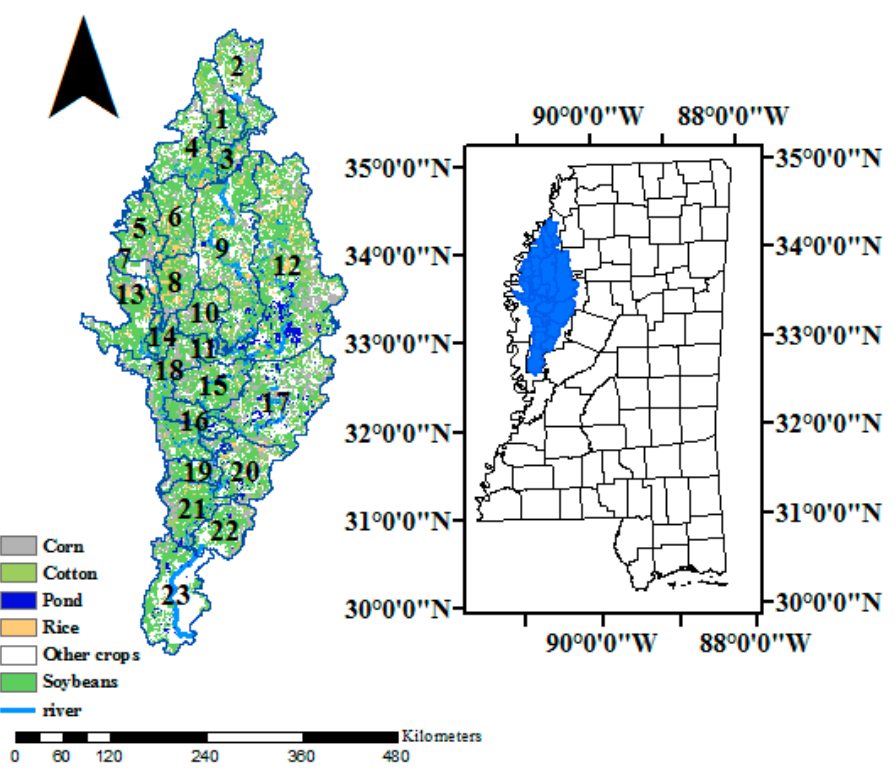
Figure 1. Location of study area and land use in Big Sunflower River Watershed.